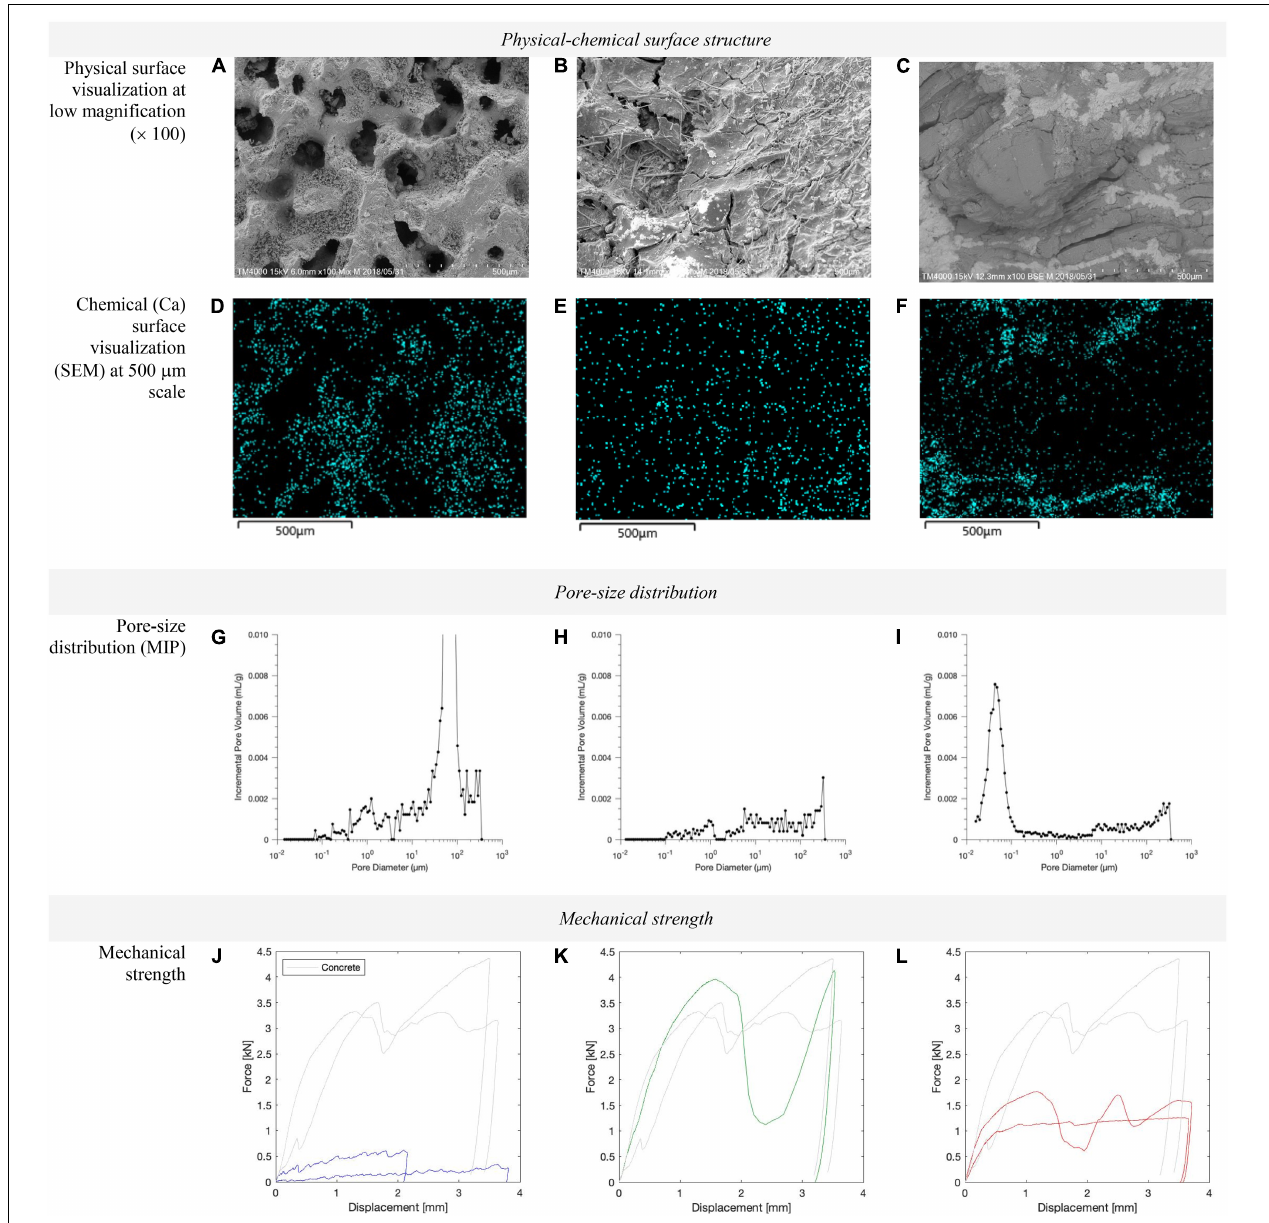
FIGURE 1 | Surface Structure of CPE (A,D,G,J) , LVMD (B,E,H,K) , and HVMD (C,F,I,L)